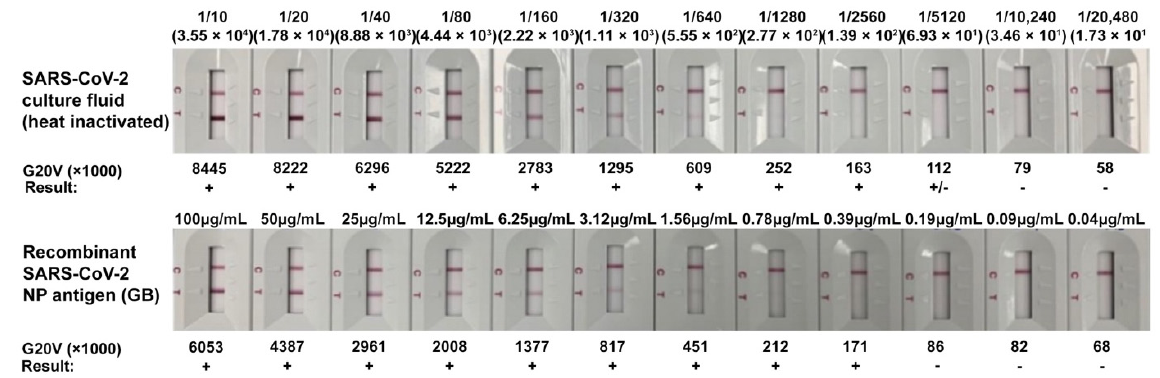
Figure 6. Limit of detection of GenBody™ COVID-19 Ag test using inactivated SARS-CoV-2 and recombinant SARS-CoV-2 NP.